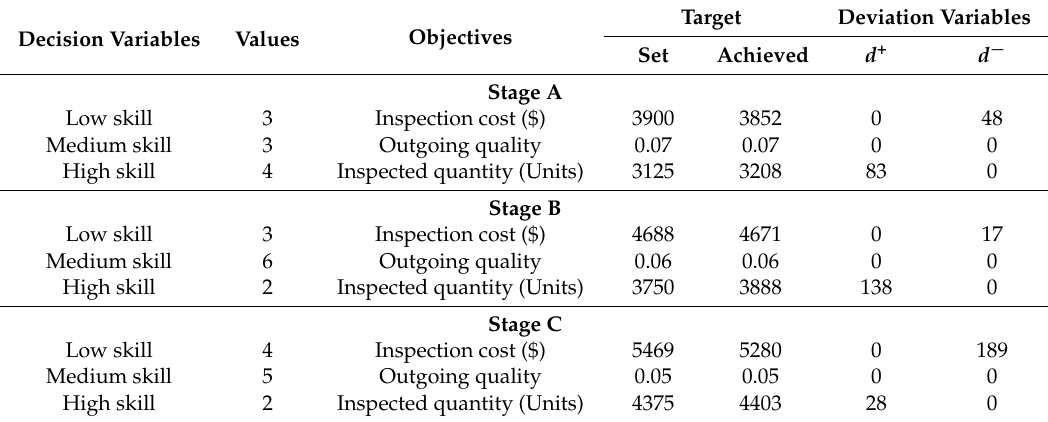
Table 3. Optimized results of decision variables and objective functions for different